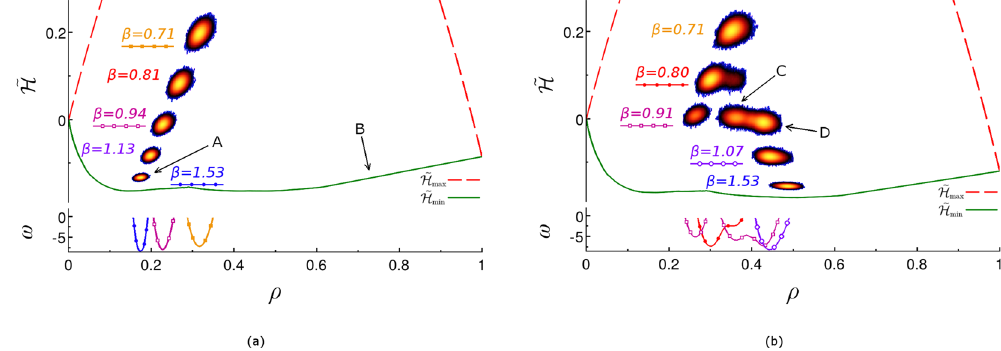
Figure 3. Upper panel: The probability distribution of visits of macrostates characterised by relative energy per ∼  (vertical axis), and density ρ (horizontal axis) for the lattice-gas model applied to aerogel sample as pore site, described in the text. The distributions at five labelled temperatures for ( a ) μ = − 4.18 and ( b ) μ = − 4.145 are shown using the same colour scheme for density of visits as in Fig. 1. The estimates for the upper and lower boundaries of the state space are shown by the dashed (red) and solid (green) lines. The arrows A, B, C and D point to the states characterised by different fluid densities (see SI 2.4 for graphical illustrations of fluid configurations). Bottom panels: Grand-potential landscapes, i.e. ω ( ρ ), obtained for three temperatures: ( a ) β = 0.71 (  ), β = 0.94 (  ) and β = 153 ( ● ); (b) β = 0.80 ( ● ), β = 0.91 (  ) and β = 1.07 ( ○ ) (see SI 1 for the values of other